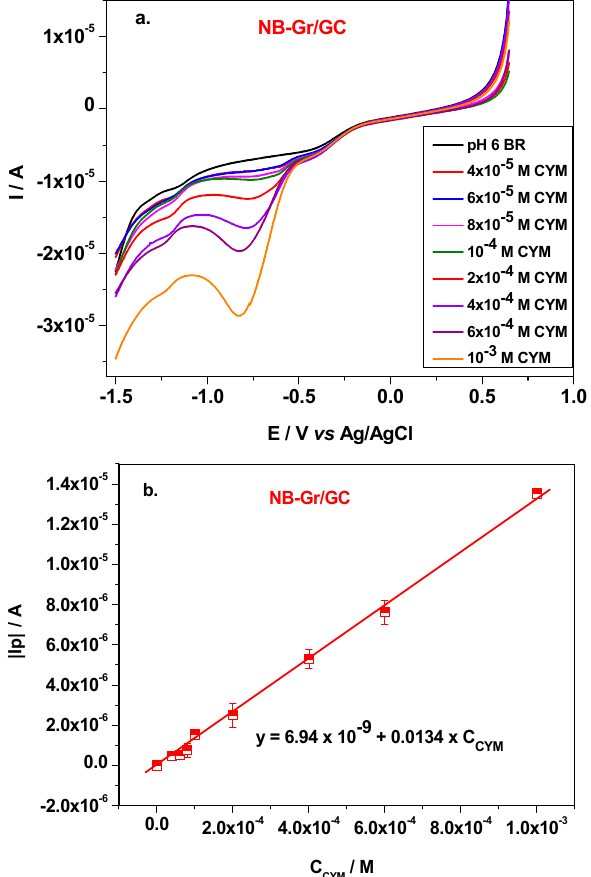
Figure 7. LSVs recorded with NB ‐ Gr/GC electrode in pH 6 BR solutions, containing various concentrations (4 × 10 − 5 –10 − 3 M) of CYM; scan rate 10 mV/s ( a ); the corresponding calibration plot within the linear range: 4 × 10 − 5 –10 − 3 M ( b ). Next, the amperometric technique was employed to further test the CYM detection with the NB ‐ Gr modified electrode. Figure 8a shows the amperometric curve recorded in pH 6 BR (potential − 0.8 V vs. Ag/AgCl) after the addition of known concentrations of cy ‐ moxanil. The corresponding calibration plot (background subtracted) has the linear re ‐ gression equation Δ I = 2.28 × 10 − 6 + 0.0164 × C CYM and is presented in Figure 8b. By am ‐ perometric measurement, both the limit of quantification and limit of detection were con ‐ siderably smaller. Hence, LOQ was determined to be 5 × 10 − 6 M, while LD was 1.51 × 10 − 6 M.